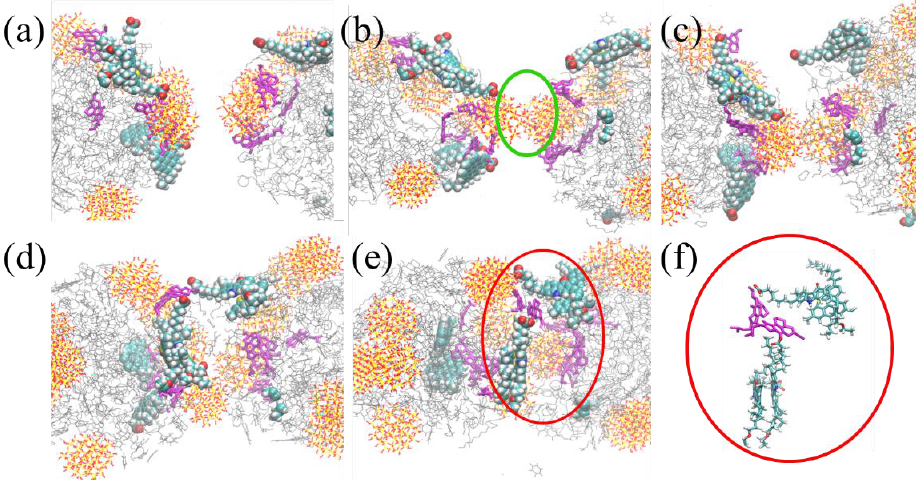
Figure 10. Oil droplet with five SNPs coalescence process. Configurational snapshot of the two oil droplets at 0 ps ( a ). Configurational snapshot of the two oil droplets at 450 ps, and the SNPs between the oil droplet interface contacted firstly in green circle ( b ). Configurational snapshot of the two oil droplets at 800 ps ( c ). Configurational snapshot of the two oil droplets at 1200 ps ( d ). Configurational snapshot of the two oil droplets at 1600 ps ( e ), and enlarged view of the interface at 1600 ps ( f ). Spherical models represent asphaltene molecules, and pink rod models represent resin molecules. Other components of oil droplet and SNPs are shown as line models.